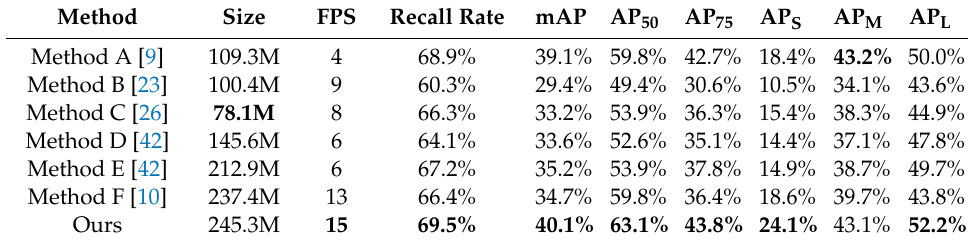
Table 6. Objective evaluation of the performance of di ff erent tra ffi c sign recognition